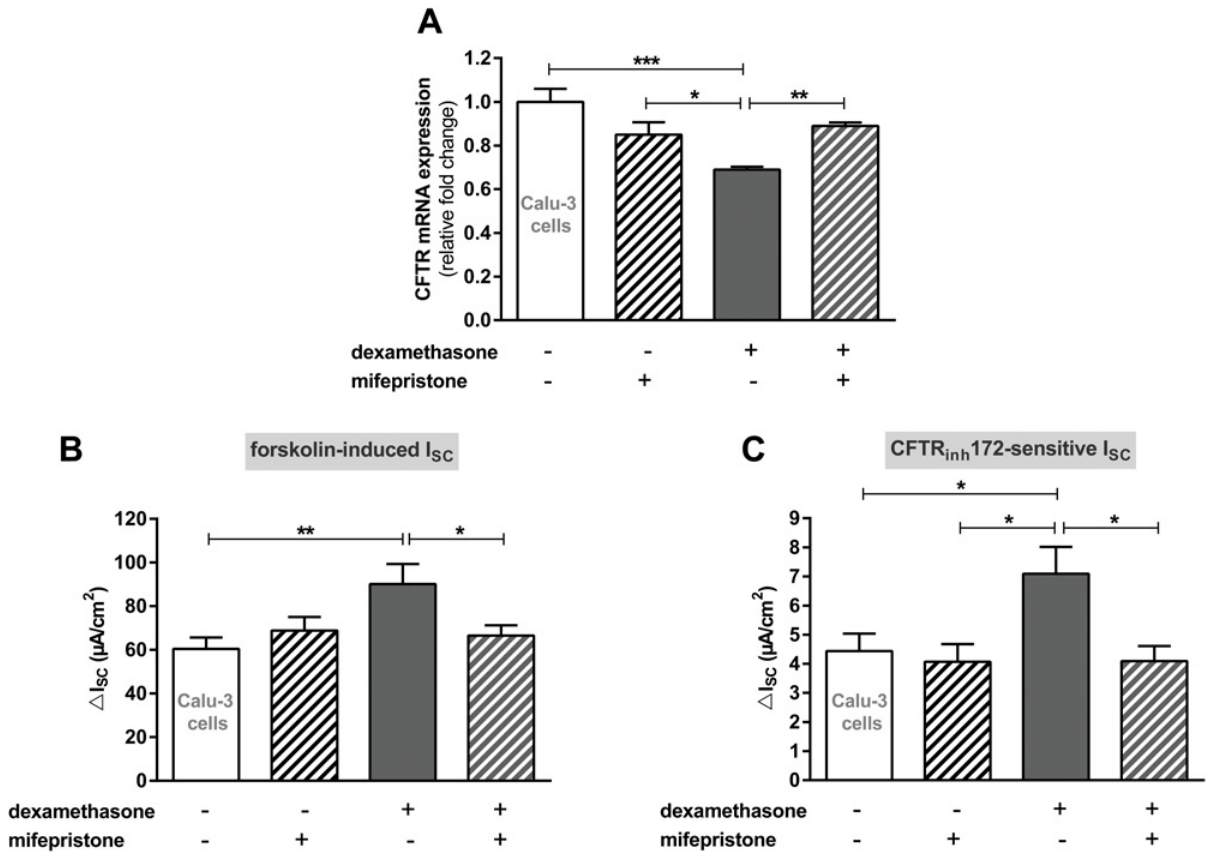
Fig 7. Mifepristone restores CFTR mRNA expression and reduces channel activity in the presence of dexamethasone in Calu-3 cells. A: Graph represents the mean + SEM for normalized CFTR mRNA expression in response to 100 nM dexamethasone and mifepristone for 24 h acquired by RT-qPCR (n = 3 – 4, * p < 0.05, ** p < 0.01, *** p < 0.001, ANOVA with Tukey's post hoc test). B/C: Graphs represent the mean + SEM of I SC in response to 100 nM dexamethasone and mifepristone for 24 h measured in Ussing chambers. B: Forskolin-induced I SC (n = 7 – 12, * p < 0.05, ** p < 0.01, ANOVA with Tukey's